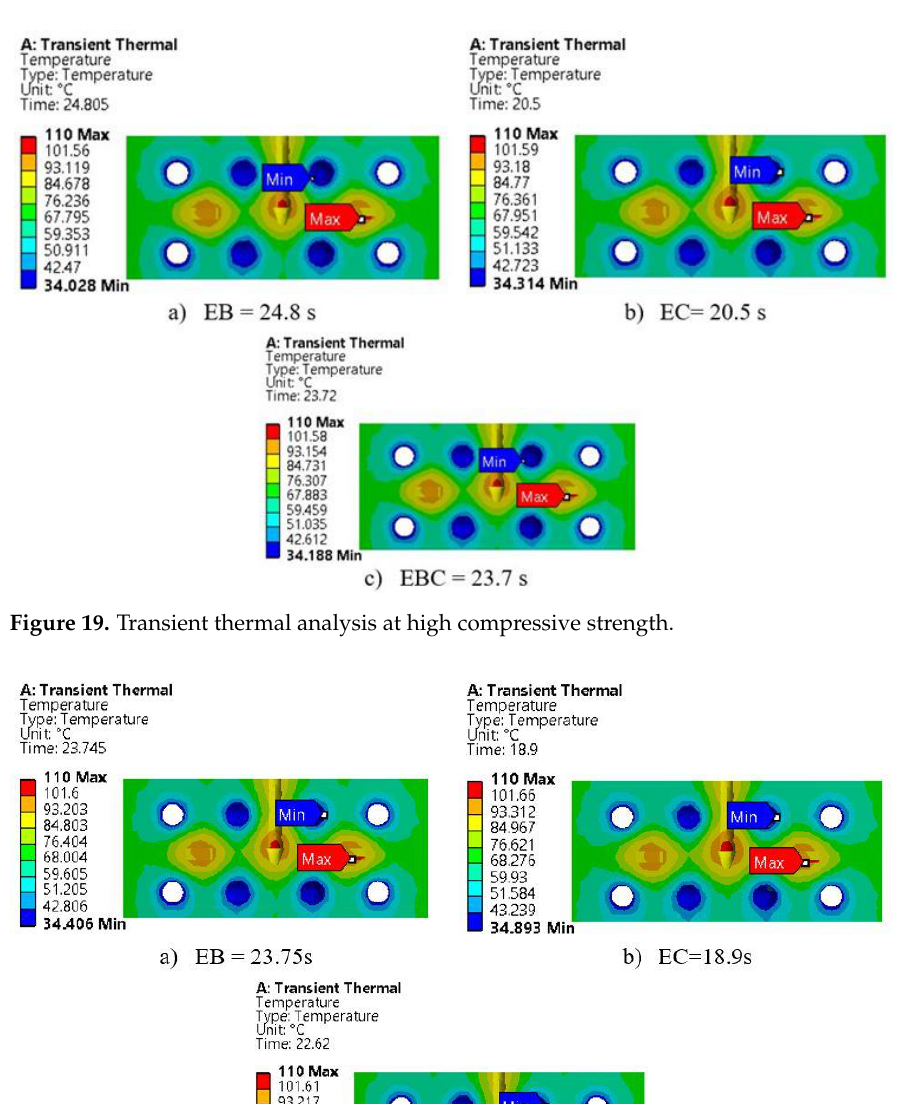
Table 12. Result of cooling time.